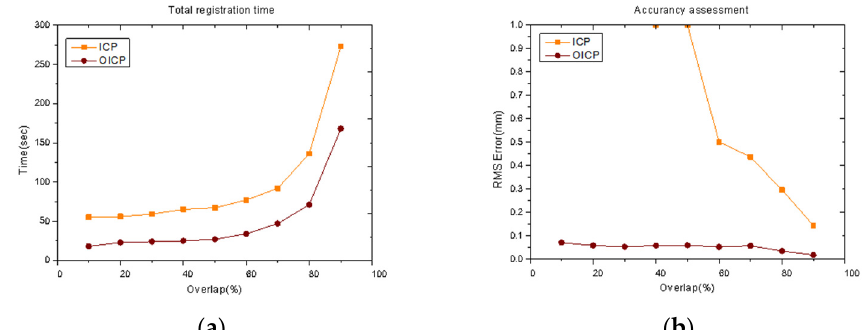
Figure 10. ( a ) Total time (s) needed for matching at different overlap rates; ( b ) the registration error based on the comparison with the three-coordinate measuring instrument.